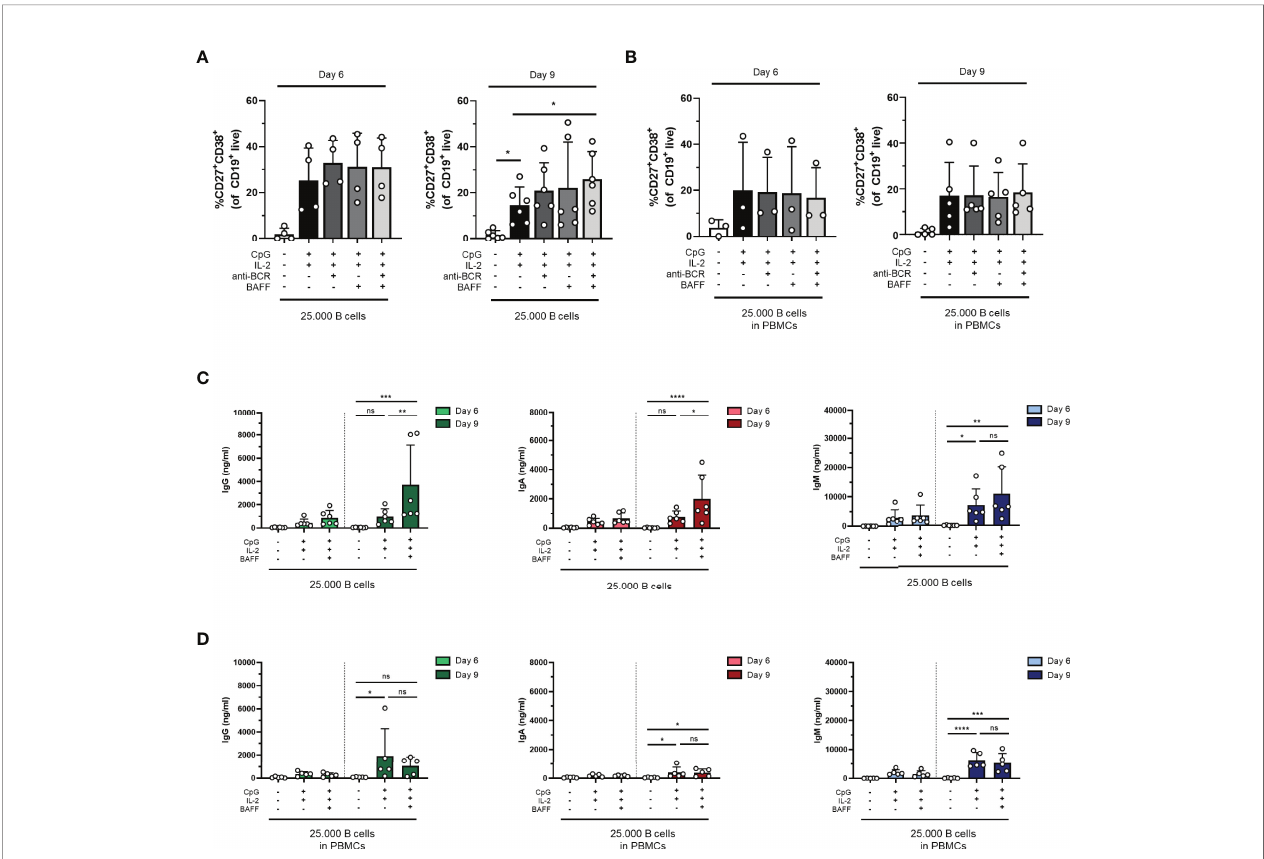
FIGURE 4 | The addition of BAFF in a T-cell-independent stimulation results in increased IgG and IgA production in isolated B-cell cultures. Human primary B cells obtained from healthy donors were stimulated under conditions described in Figure 3A (condition IV) and Supplementary Figure 4A (condition IV.2, PBMC cultures) with or without anti-BCR [anti-Ig F(ab) 2 mix (5 µg/ml) targeting IgM, IgG, and IgA] and/or BAFF (100 ng/ml). Frequencies of CD27 + CD38 + B cells on day 6 and day 9 in (A) condition IV and (B) condition IV.2 ( n = 3 – 5). (C, D) Total secretion of IgG, IgA, and IgM measured in culture supernatants of eligible conditions after 6 and 9 days (C) without PBMCs (condition IV) and (D) as PBMC culture (condition IV.2). Each data point represents the mean of an individual donor with duplicate culture measurements. Mean values are represented by bars and the error bars depict SEM. P -values were calculated using one-way ANOVA with Dunnett ’ s multiple comparison test (A, B) or two-way ANOVA with Sidak ’ s multiple comparison test (C, D) . * P ≤ 0.05, ** P ≤ 0.01, *** P ≤ 0.001, **** P ≤ 0.0001. ns, not signi fi